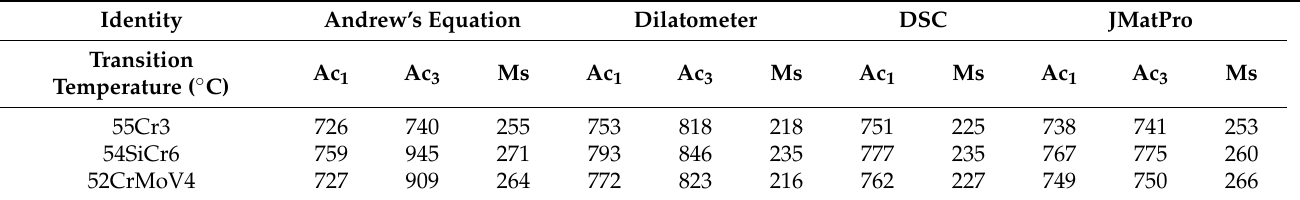
Figure 1. Critical transformation temperatures for the three steels: ( a ) Ac 1 and Ac 3 using dilatometer, ( b ) Ms temperature using dilatometer, and ( c ) DSC phase transition. Table 3. Critical transformation temperatures.